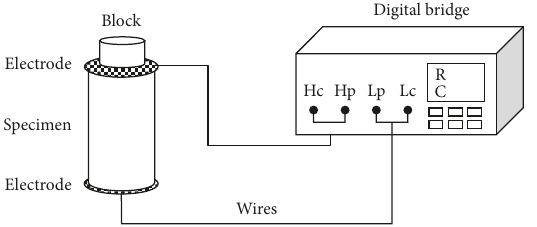
Figure 2: Schematic of electrical resistivity measurement.